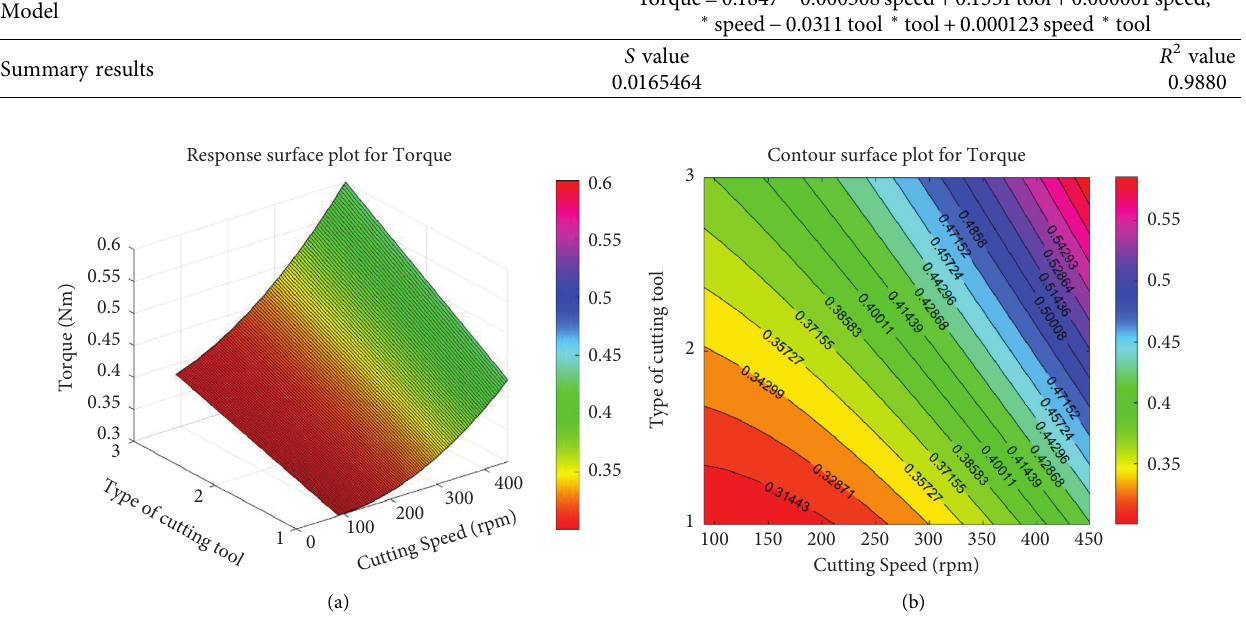
Figure 8: (a)Response surface graph for Torque (cutting Speed vs. type of cutting tool). (b)Contour surface plot for Torque (cutting Speed vs. type of cutting tool). Table 13: Regression model and summary results for